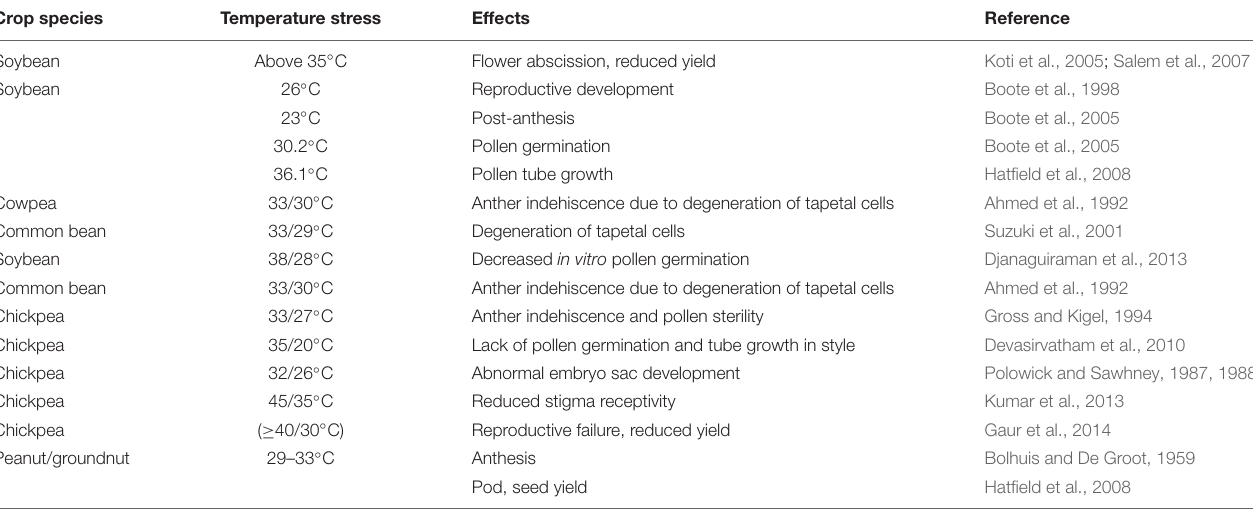
TABLE 2 | Effect of heat stress on both reproductive function, male and female reproductive tissue in some legume